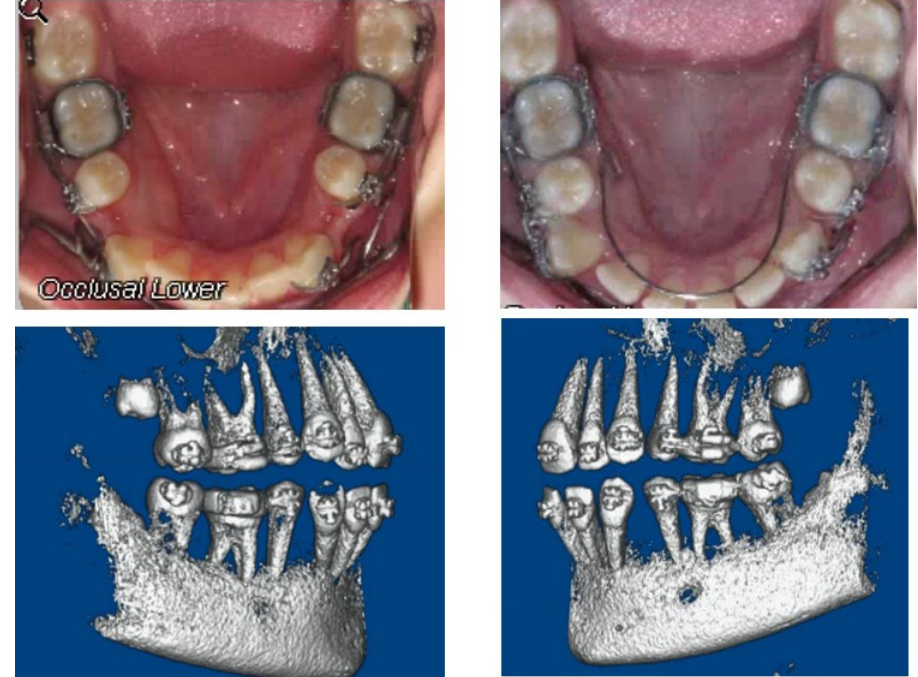
Figure 3. A case in the LIPUS group at the beginning (top left) and two months of the treatment (top right) the patient’s lower right side was treated by LIPUS and lower left side was control. CBCT scan showing root angulation after canine retraction (bottom left LIPUS treated side and right is control).